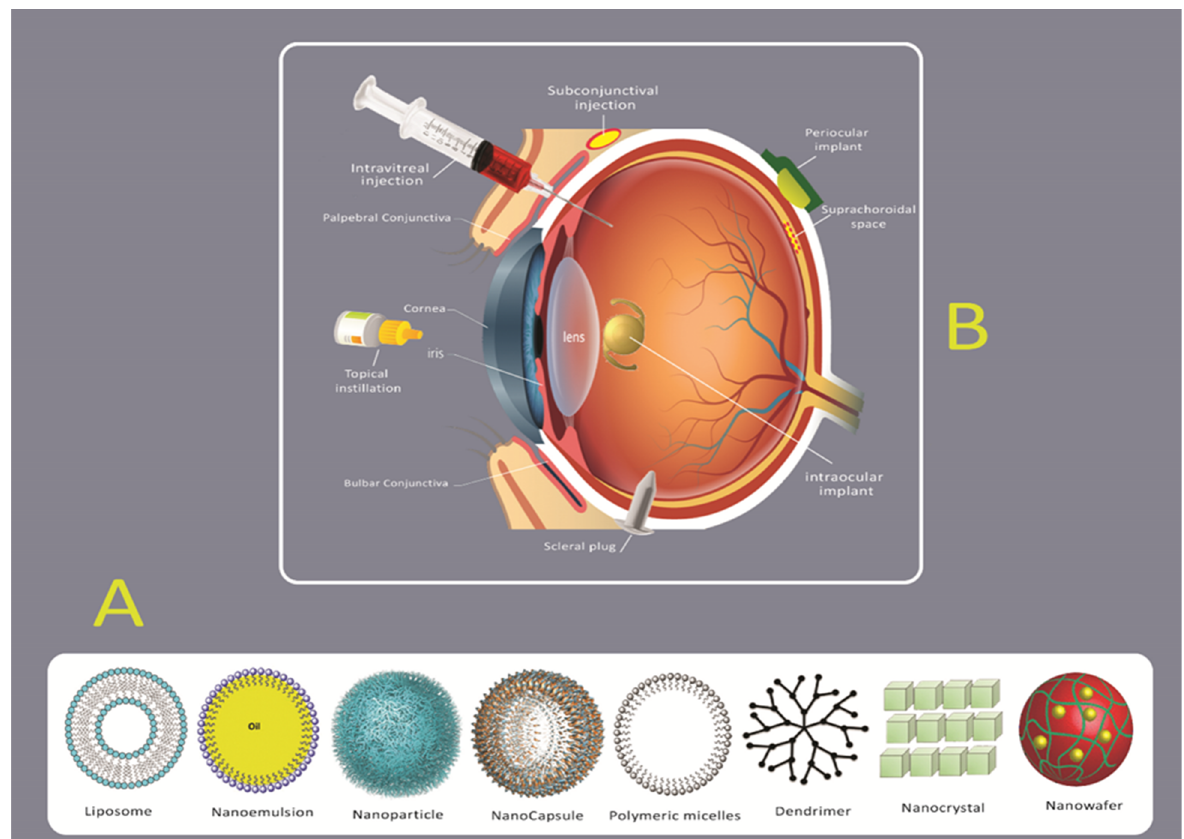
Figure 2. ( A ) Illustration of different types of formulation such as liposomes, nanocarriers, emulsions, nanocapsule, poly- meric nanoparticles, dendrimers, nanocrystal and nanowafers for drug delivery into the eye. ( B ) Schematic representation of different strategies for drug delivery to the posterior segment of the eye through topical administration, subconjunctival injection, subretinal injection and intravitreal injection.